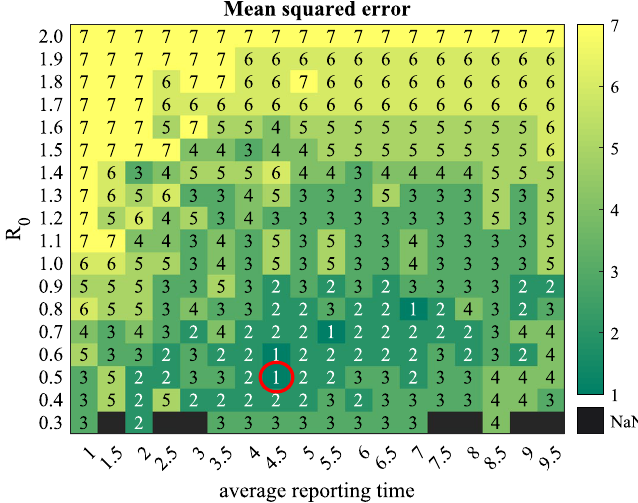
Figure 3. A sensitivity analysis. Mean-squared error (mse) between the time series of the total confirmed cases (or cumulative new cases per day) of March 25, 2020 to May 4, 2020 and simulated results for a different combination of basic reproductive number and average reporting time (in days). The light-colored boxes represent more mse than dark-colored boxes. The color boxes with number “1” means that mse ≤ 3, number “2” means that 3 < mse ≤ 10, number “3” means that 10 < mse ≤ 50, number “4” means that 50 < mse ≤100, number “5” means that 100 < mse ≤ 500 , number “6” means that 500 < mse ≤ 1000, number “7” means that 1000 < mse. More than 80% times epidemic dies out in the combinations of the black squares, and confirmed cases are less than 10. The minimum error combination is showing by the red circle. We estimate R 0 = 0.55 and average reporting time= 4.79 days.